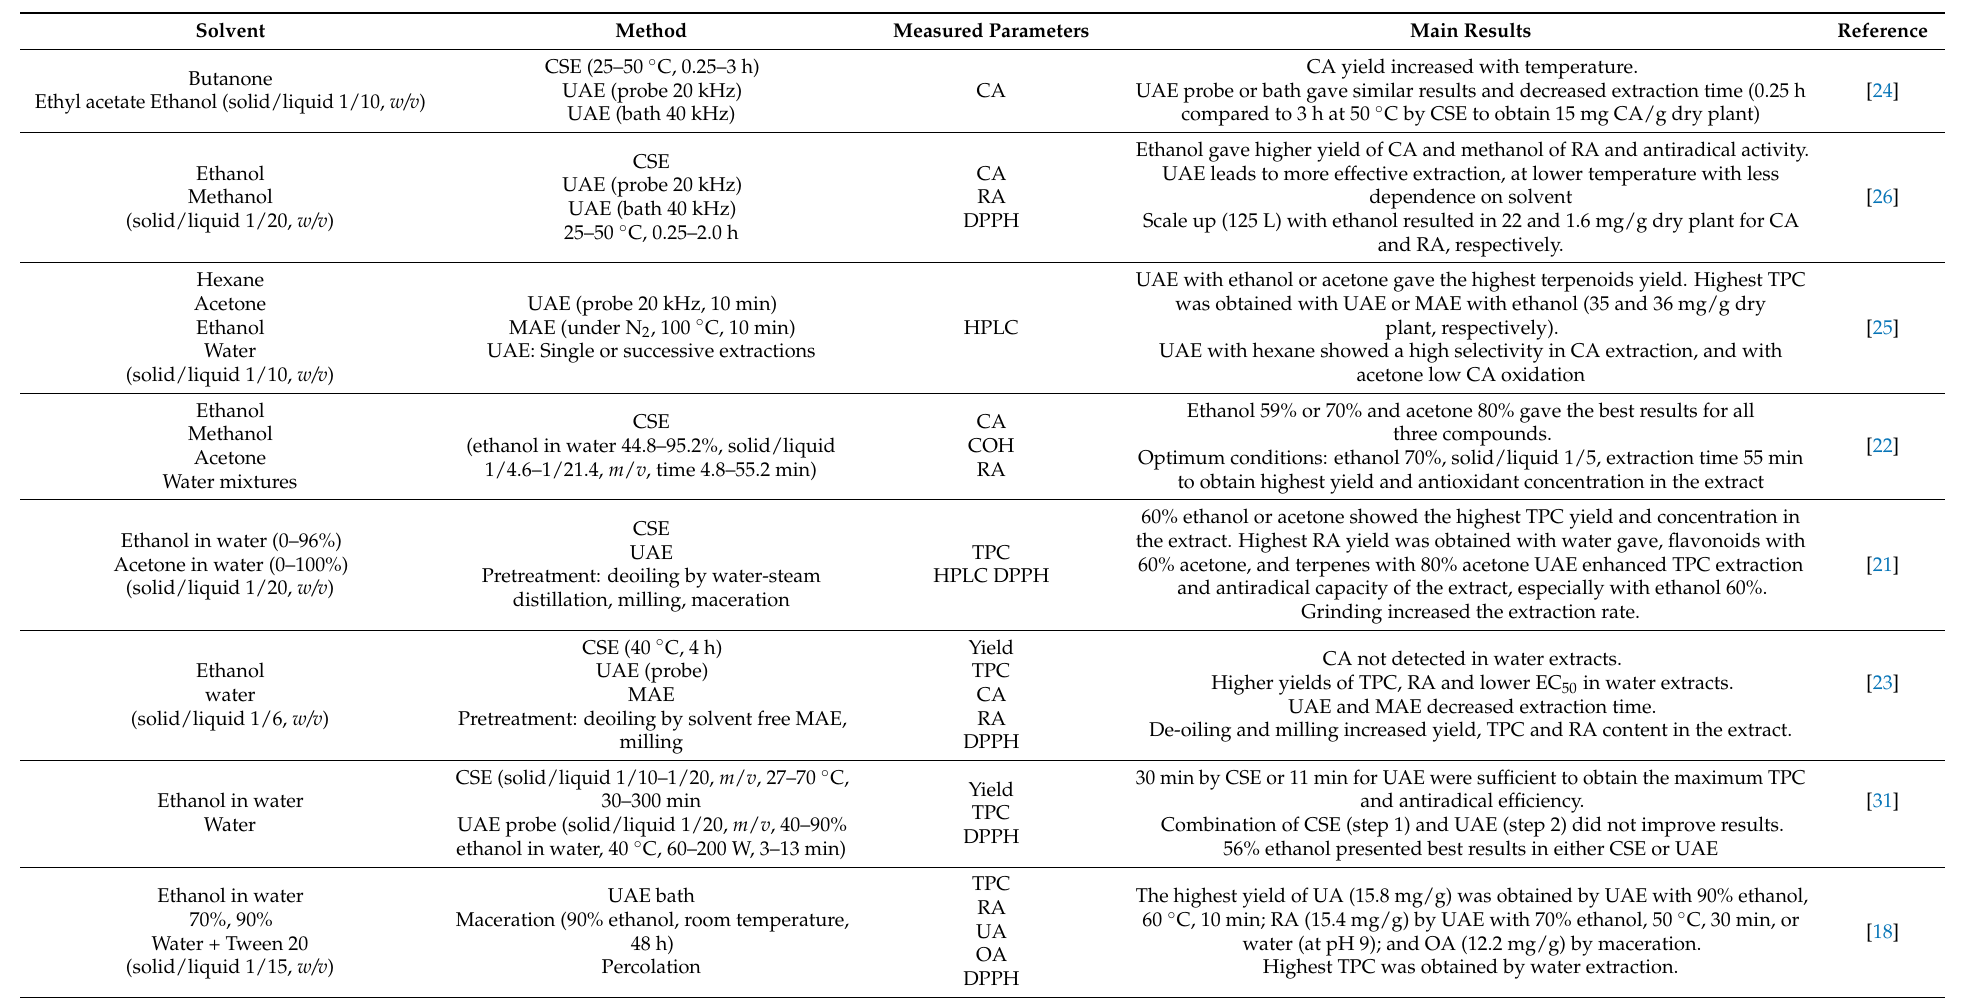
Table 1. Solvents and methods reported in literature for the extraction of phenolic compounds from